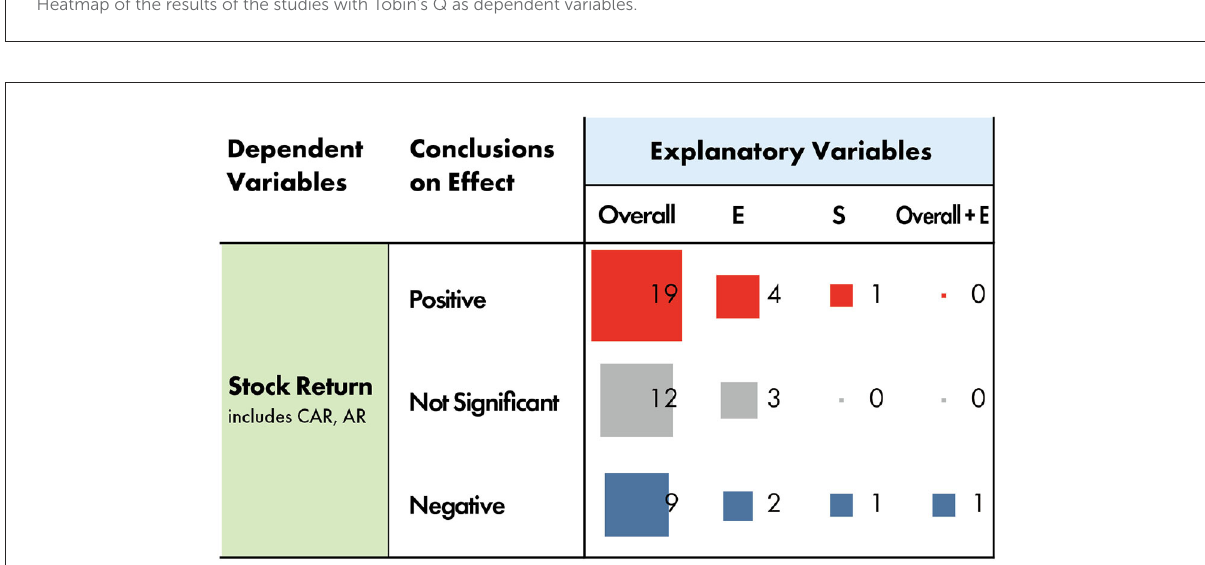
FIGURE7 Heatmap of the results of the studies with Stock Return as dependent